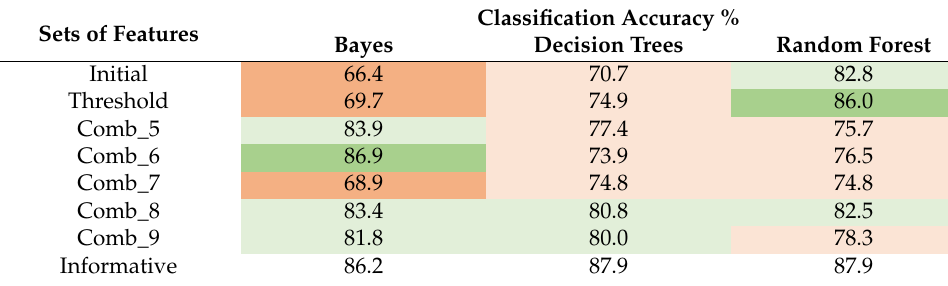
Table 5. Classification results for different sets of